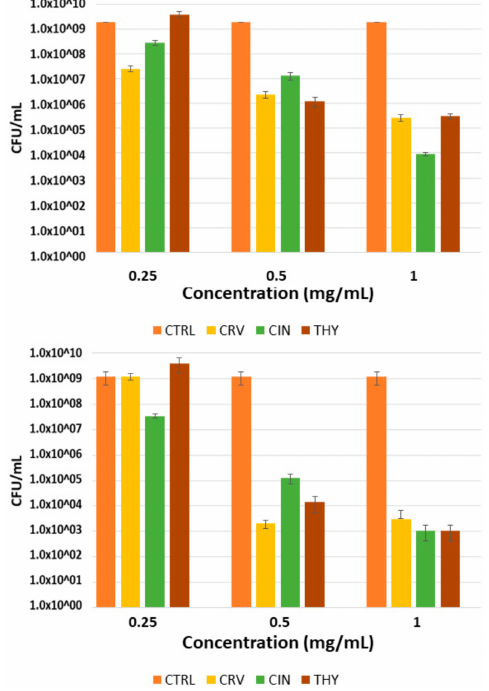
Figure 5. Effect of EOs components at different concentrations on S. aureus biofilm: elimination